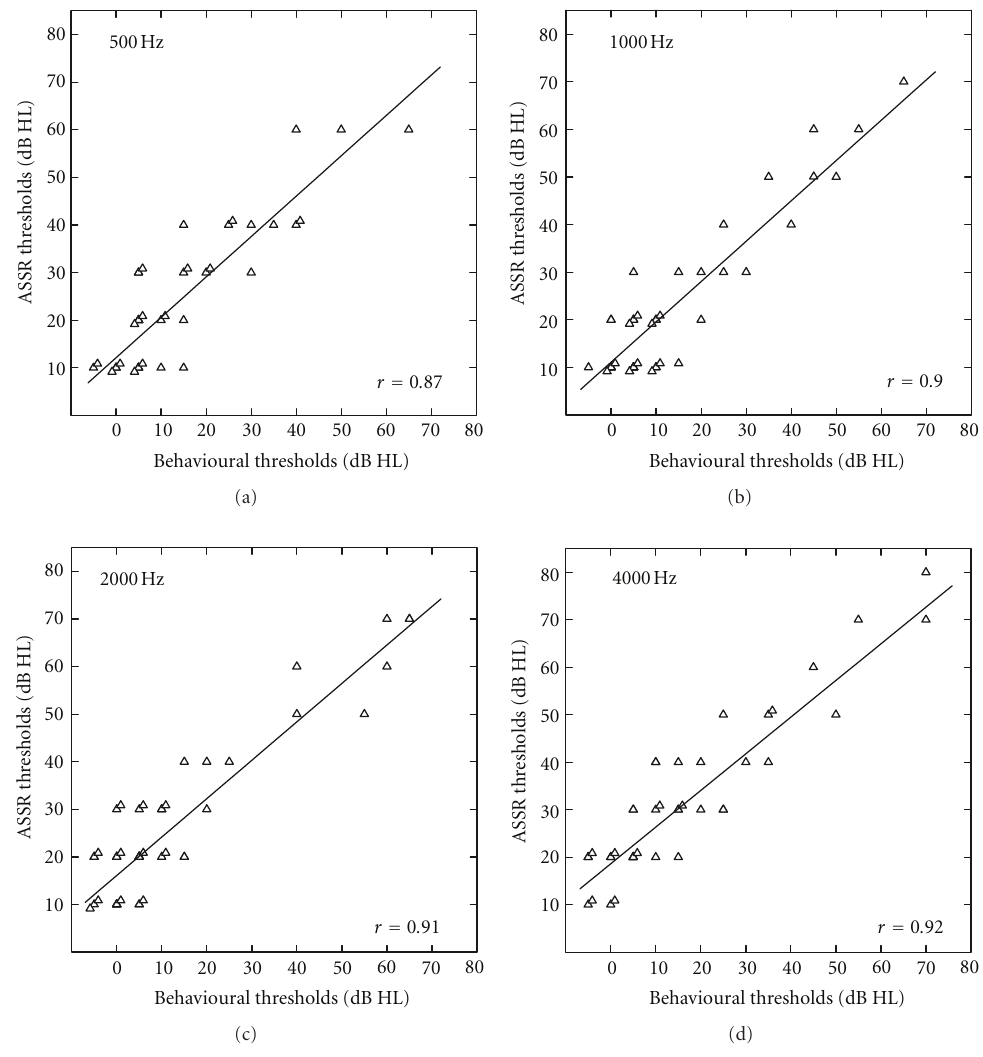
Figure 2: Linear regression analysis comparing ASSR thresholds with behavioural pure-tone thresholds at 500, 1000, 2000, and 4000Hz with the correlation coe ffi cient r in the lower right-hand corner of each plot. Overlapping data points are shifted by ± 1 dB in both directions to improve the readability of the figure.